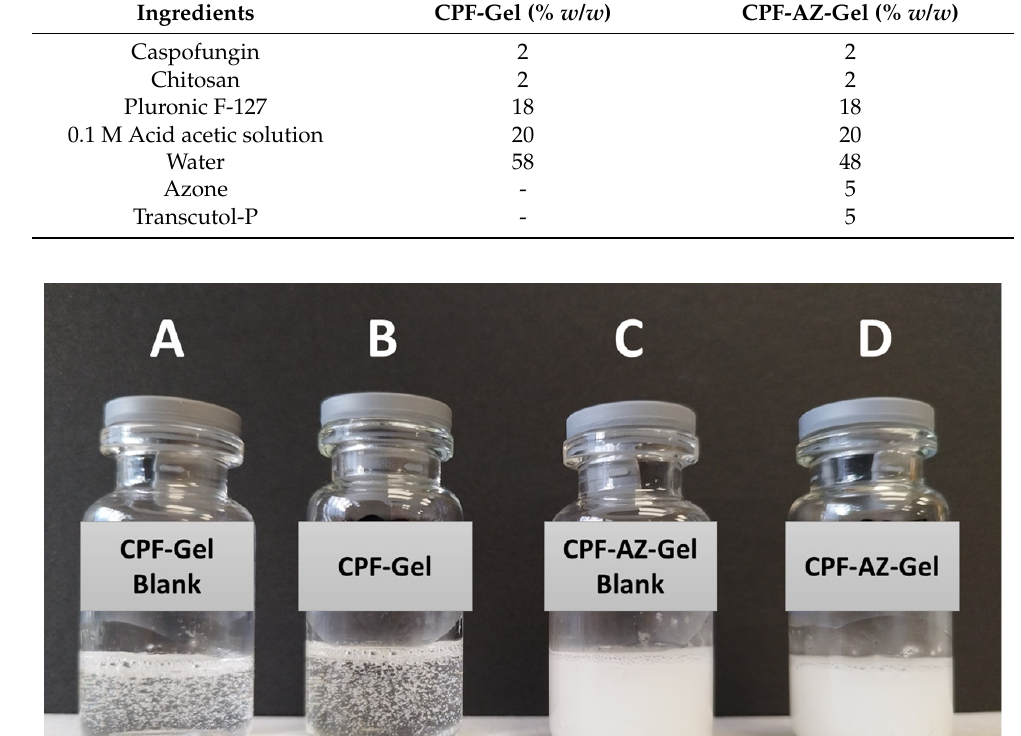
Table 1. Composition formula of caspofungin-loaded gels.